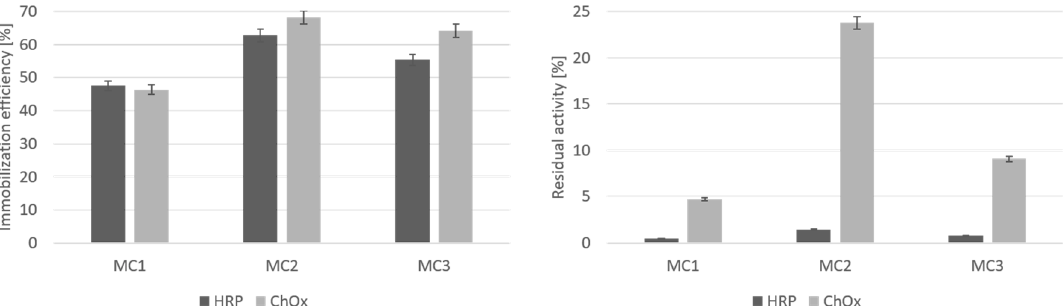
Figure 7. Immobilization efficiency and residual activity of HRP and ChOx on different chitosan functionalized metal oxide micro- and nanoparticles with GA activation.